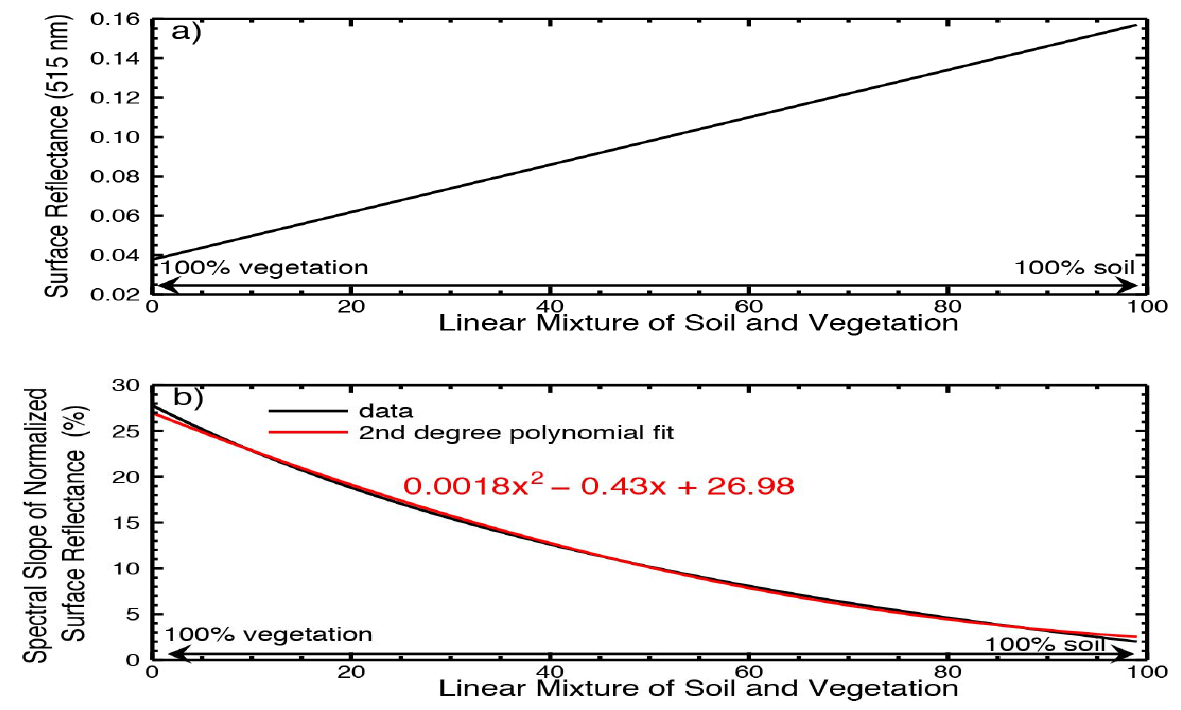
Figure 4. ( a ) The change in surface reflectance at 515 nm for 100 linear mixtures of bare soil and vegetated surface reflectances (from Figure 3). ( b ) The change in spectral slope (in %) of the surface reflectance between 1,565 and 1,634 nm, normalized by reflectance at 1,565 nm for the same linear mixtures. A 2nd degree polynomial fit (red) of the relationship is also shown.